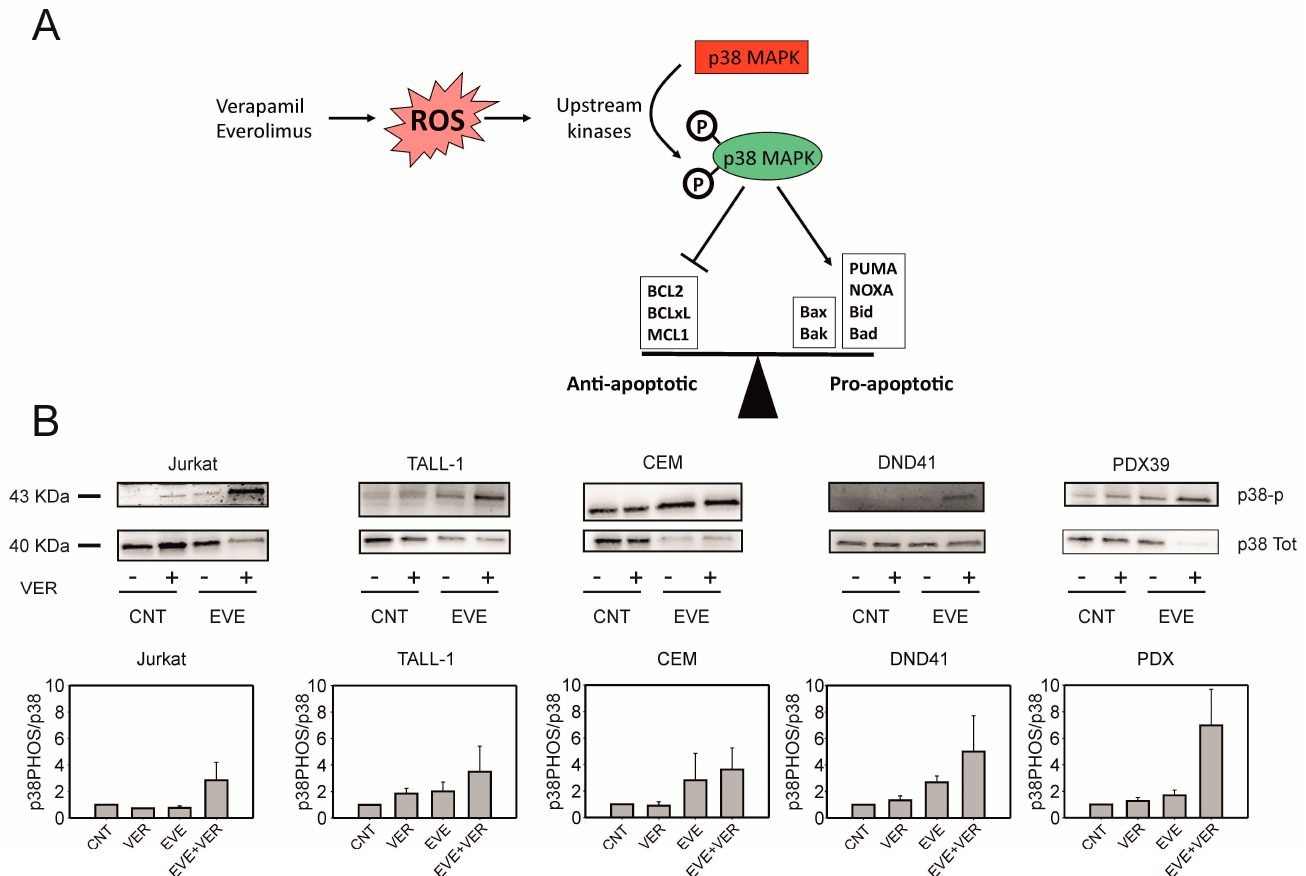
Figure 5. Everolimus and verapamil induce the phosphorylation of p38 MAPK. ( A ) A working model connecting ROS, p38 MAPK activation, and the induction of apoptosis induced by verapamil and everolimus. ( B ) p38 MAPK phosphorylation in T-ALL cells treated with everolimus (EVE, 10 µ M) and/or verapamil (VER, 20 ng/mL) for 24 h. Shown are immunoblots from representa- tive experiments and plots of phospho-p38/p38 ratios with means and standard error bars from three